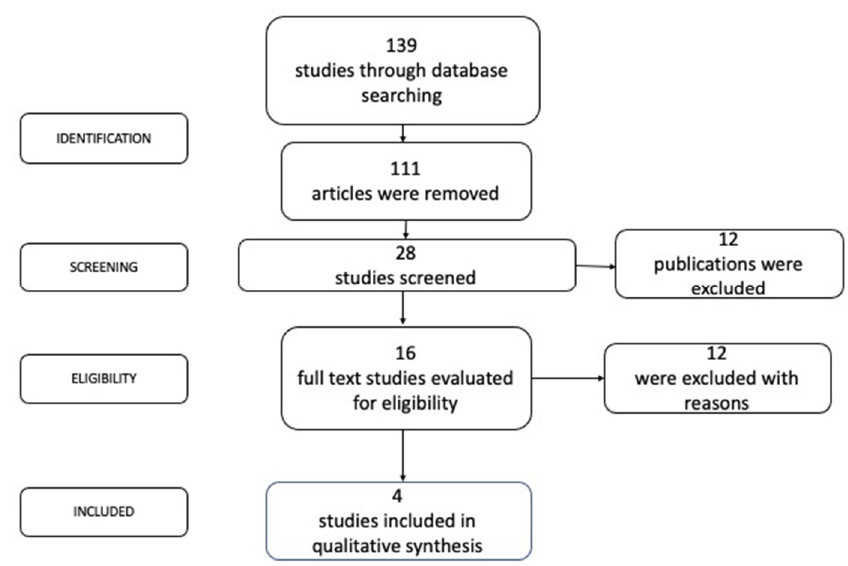
Figure 1. Search strategy for antibiotic resistance in PI.